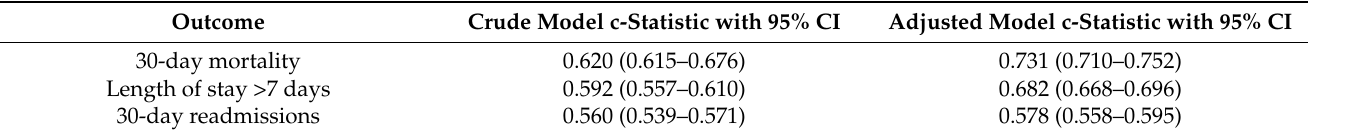
Table 4. Prediction performance of continuous HFRS mixed models for outcomes. Models adjusted for age, sex, Charlson index and socioeconomic status.